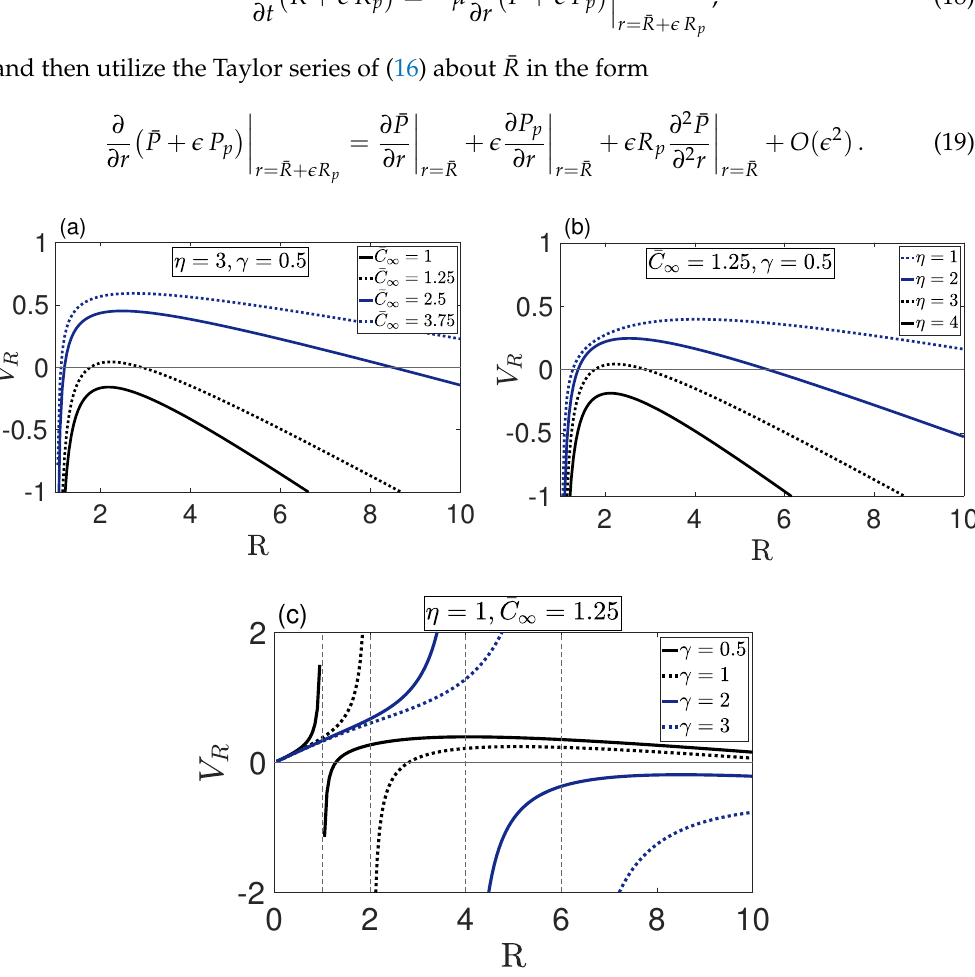
Figure 1. Tumor growth rate, V R , vs. R for various values of nutrient supply ¯ C ∞ in ( a ), nutrient consumption η in ( b ) and surface tension γ in ( c ). A maximum of two plausible steady-state solutions existed, which could be stable ( dV R / dR < 0) or unstable ( dV R / dR > 0). It could be seen that the maximum of two steady-state solutions was achieved for sufficient nutrient supply ( a ), low consumption rate ( b ) and low surface tension ( c